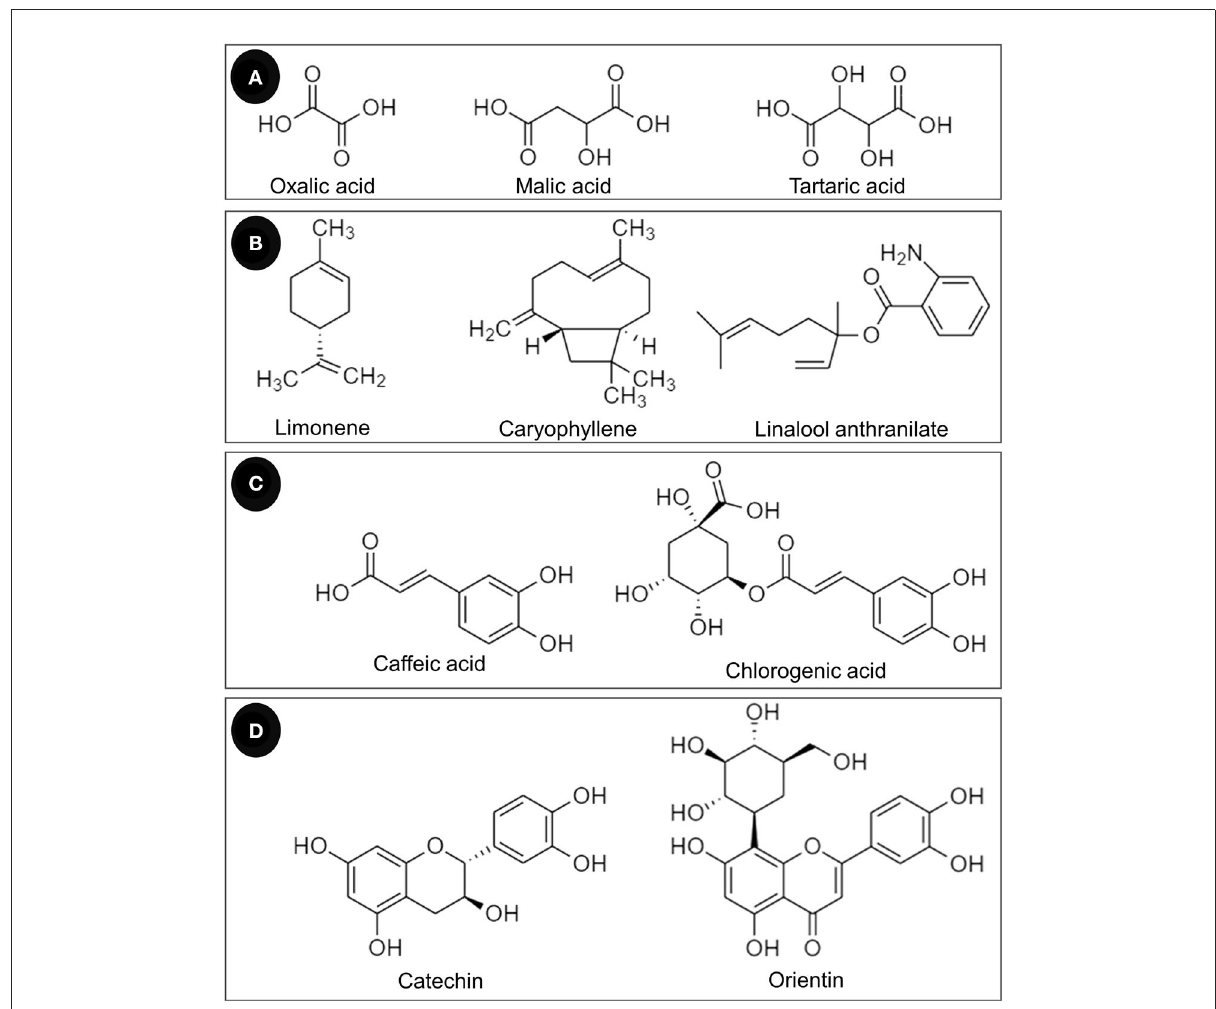
FIGURE4 Chemical constituents of T. indica leaves classified as (A) organic acids, (B) terpenoids, (C) phenolic acids, and (D)